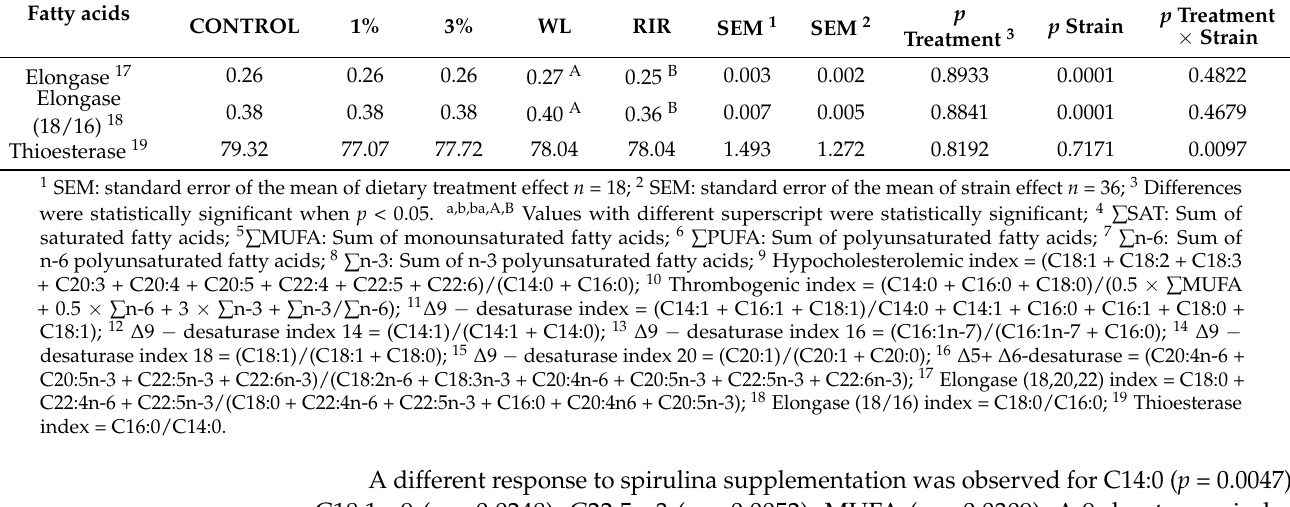
Table 7. Little changes were observed on lipid oxidation by short-term spirulina supplemen- tation. Malondialdehyde (MDA) concentration was higher at the initial time of incubation ( p = 0.0209) in those spirulina-supplemented groups, whereas statistical differences